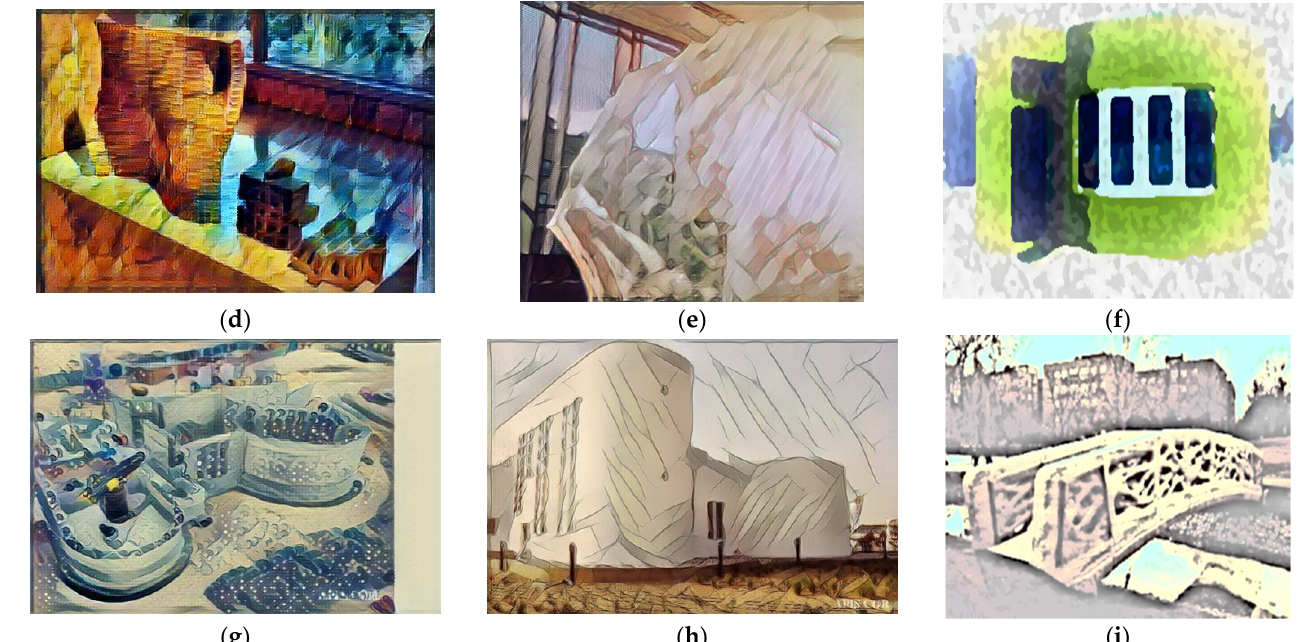
Figure 2. Examples of 3D printed concrete buildings and structures: ( a ) one of the first houses; ( b ) multi-story house; ( c ) concrete artificial reefs; ( d ) PolyBricks blocks; ( e ) construction modeled on the work of silkworms; ( f ) a house made according to the design of Apis Cor; ( g ) the construction phase of the largest building; ( h ) the largest 3D-printed building; ( i ) Castilla-La Mancha pedestrian bridge. Images created by A. Skoratko (inspired by [34,36,41,42]).